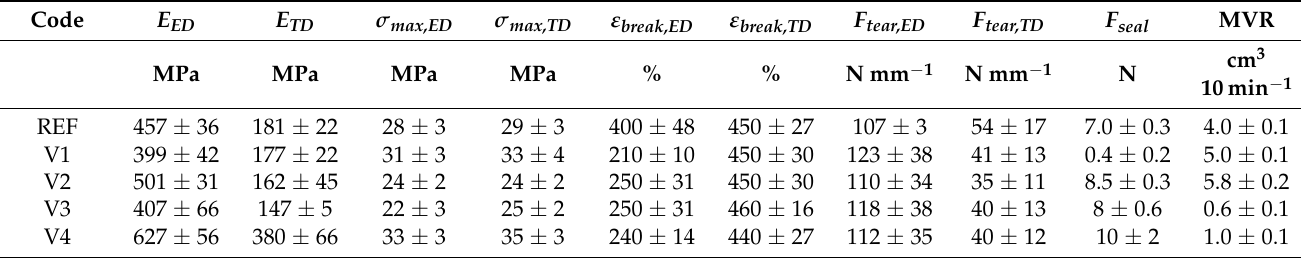
Table 1. MVR and mechanical properties of REF and modified compounds V1 to V4 in the extrusion direction (ED) and transverse direction (TD).